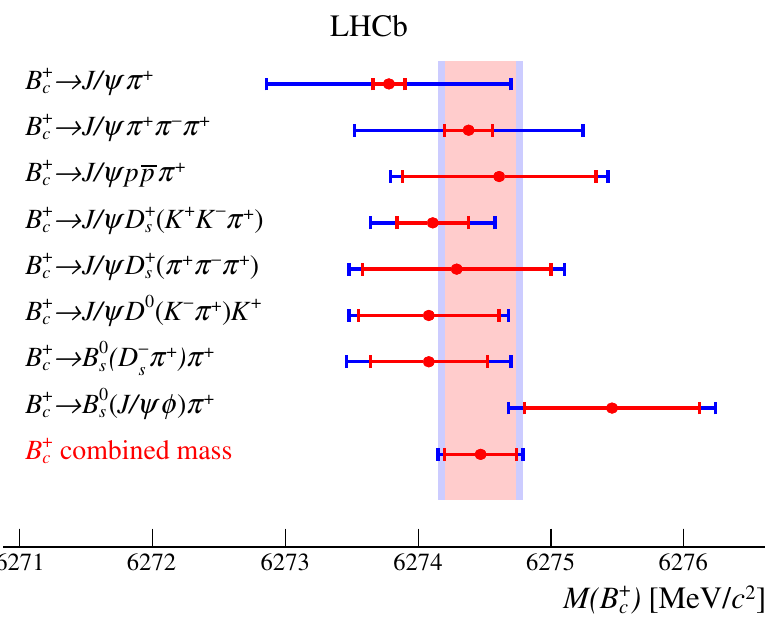
Figure 3. Individual B + mass measurements and their combination. The red (inner) cross-bars c show the statistical uncertainties, and the blue (outer) cross-bars show the total uncertainties.